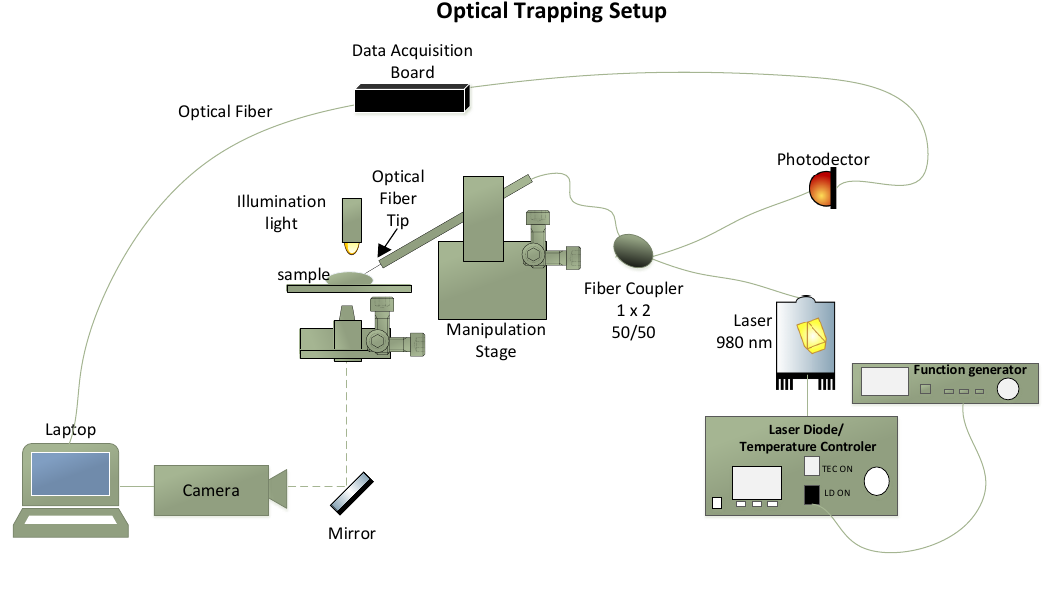
Figure 3. Optical manipulation